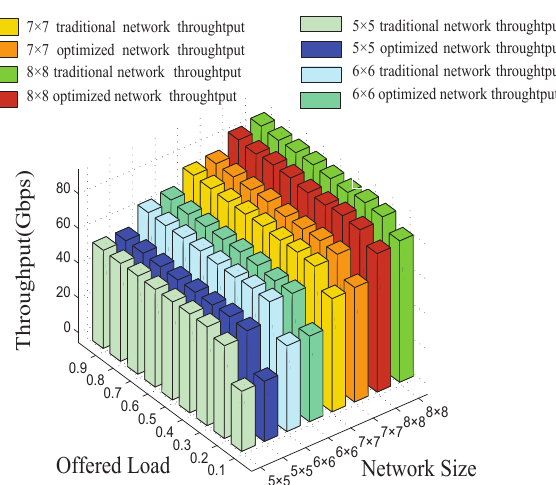
Figure 10. The network throughput in M × N mesh-based